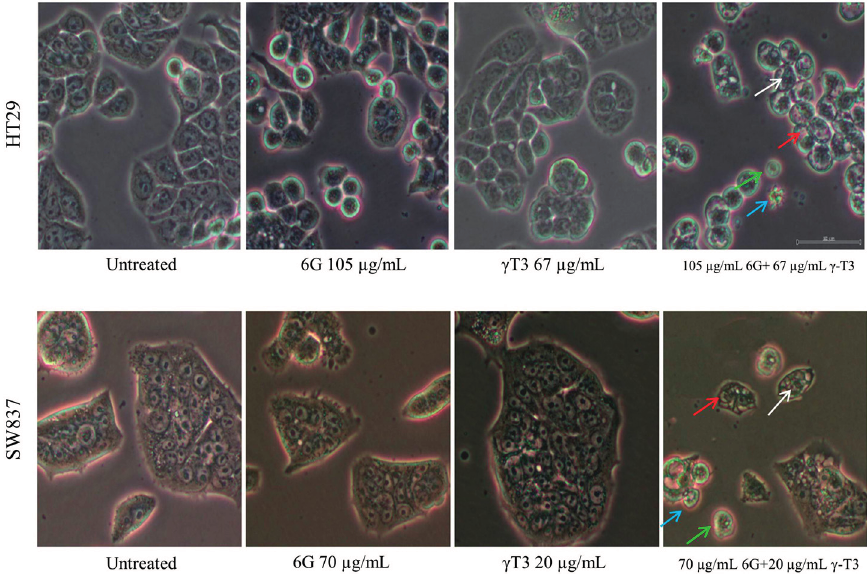
Figure 5. Phase-contrast microscopic observation of untreated HT-29 and SW837 cells displayed intact, strong attachment with adjacent cells as well as prominent appearance of cytoplasm and nucleus. Cells that were treated with 6G and γ -T3 alone also displayed intact